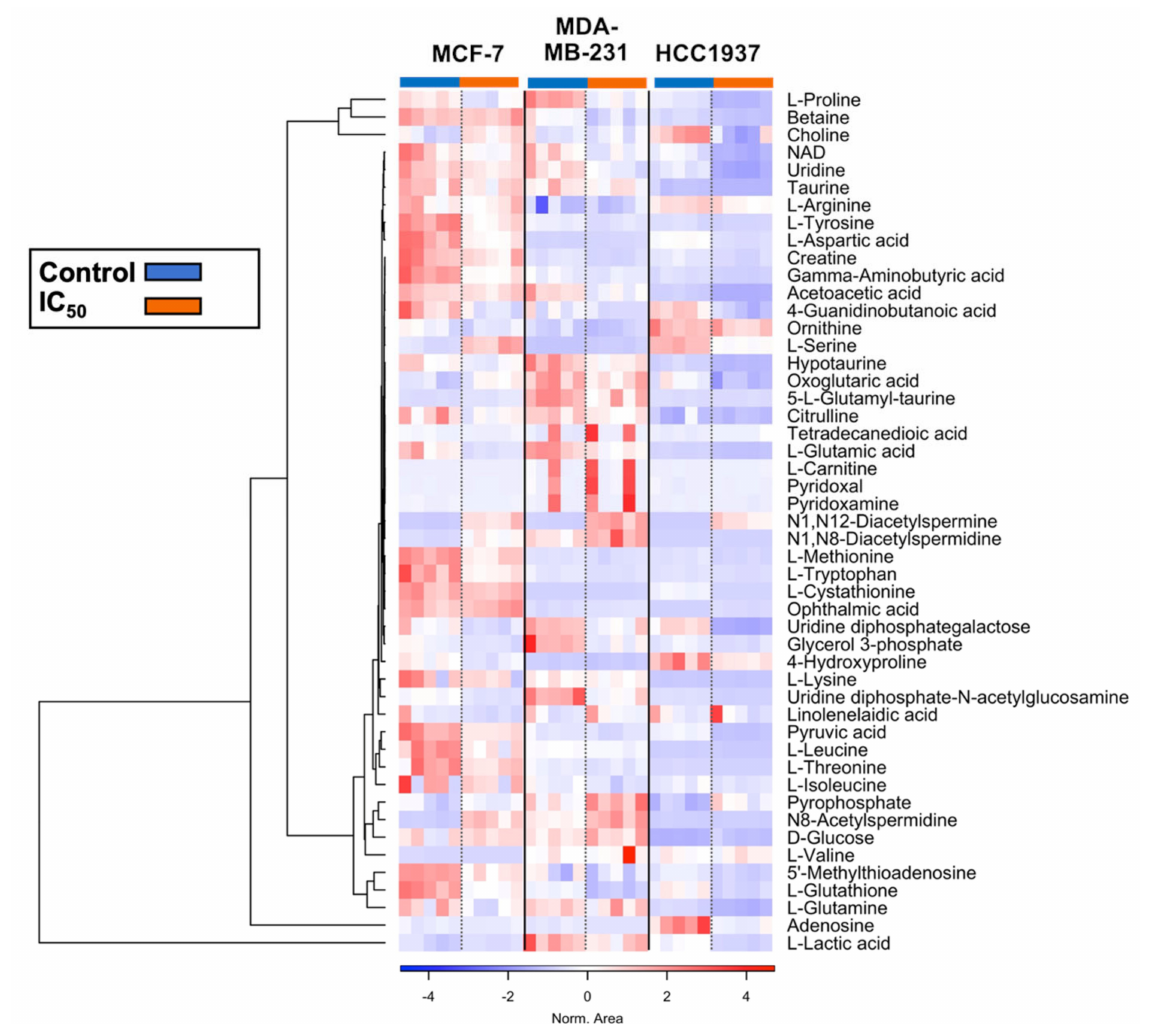
Figure 6. Heatmap cluster analysis of relevant metabolites associated with the pathways altered upon exposure to olaparib in MCF7 (10 µ M), MDA-MB-231 (14 µ M), and HCC1937 (150 µ M) cells for seven days. Clustering and distance function are Ward and Euclidean, respectively. Normalized areas indicate chromatographic peaks areas that have been normalized based on the QC samples to compensate for batch